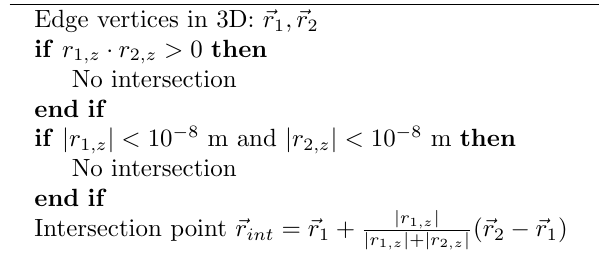
Figure 16: One iteration of the simulation loop. Algorithm 4 Edge-plane intersection